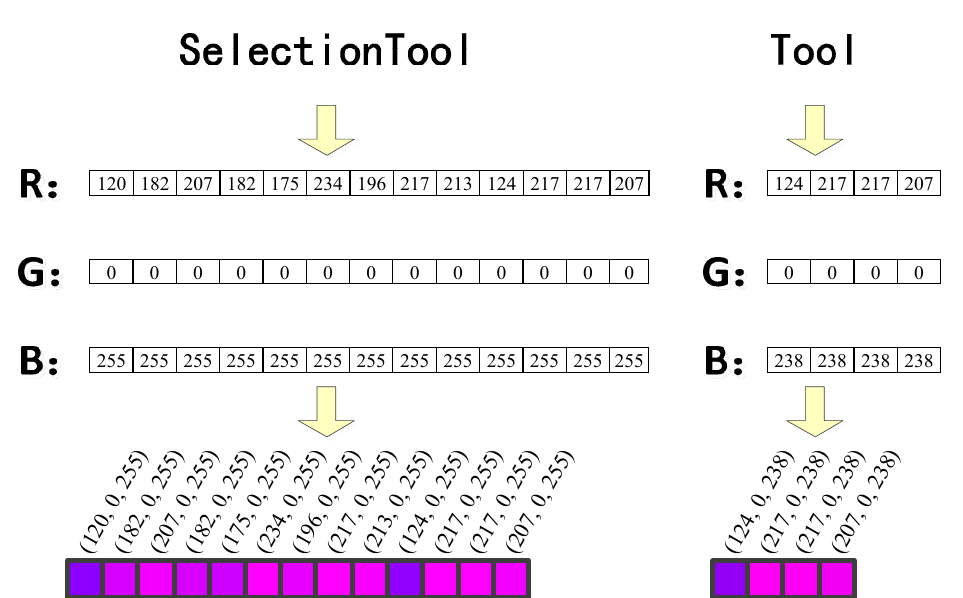
Figure 4. Schematic diagram of the colored UML representation for the class names of SelectionTool and Tool.